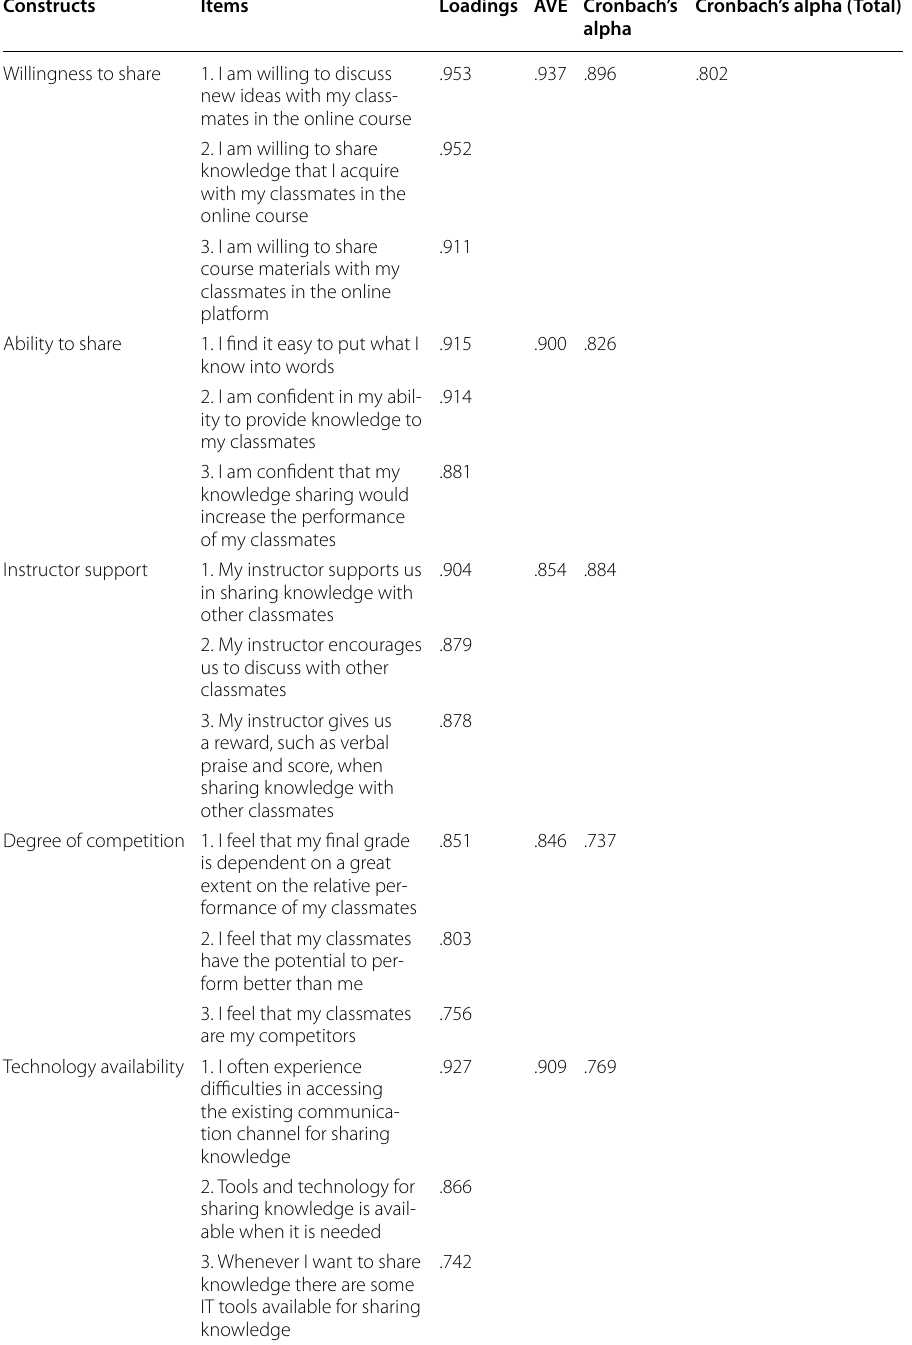
Table 1 Validity and reliability of research variables using factor analysis and Cronbach’s test Constructs Willingness to